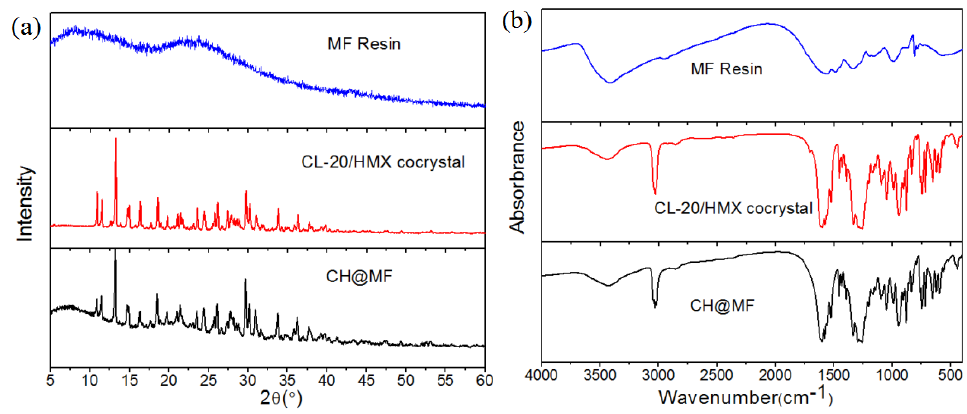
Figure 5. XRD ( a ) and IR ( b ) spectra of the MF resin, CL-20/HMX cocrystal and CH@MF − 3 composite.